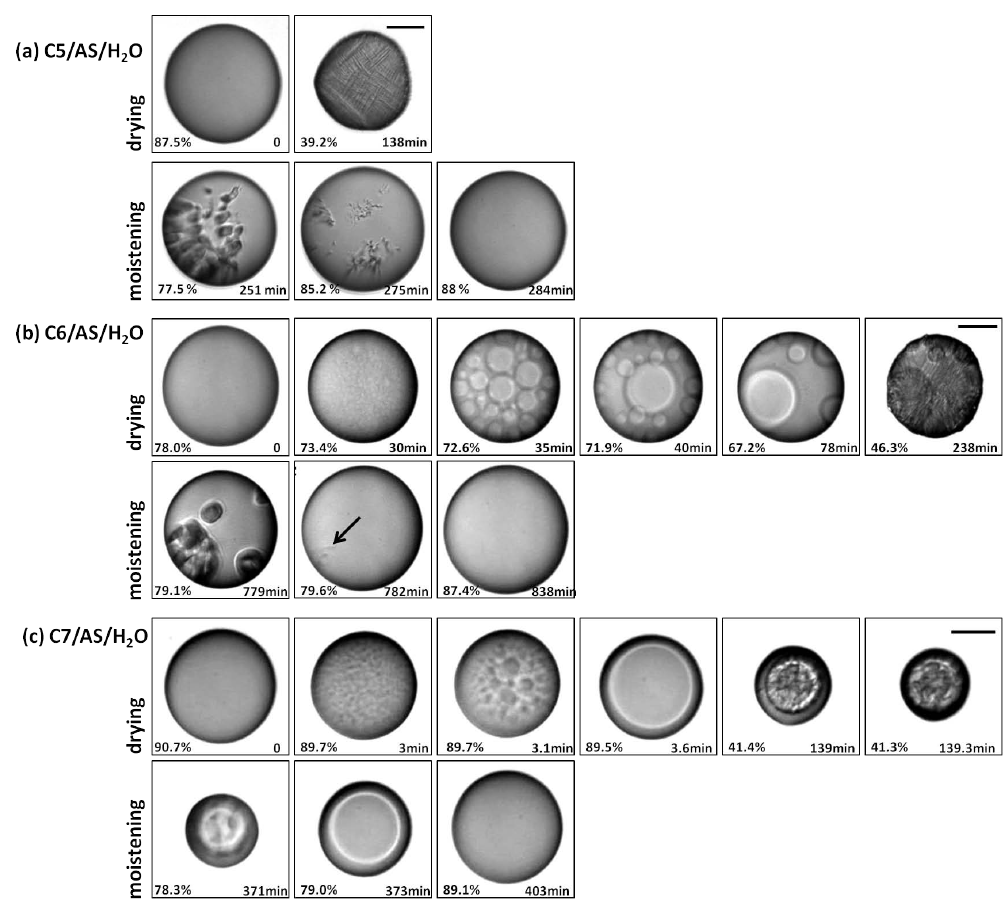
Fig. 2. Humidity cycles of (a) C5/AS/H 2 O particle (top rows, dRH/d t = ± 0.33%min − 1 ), (b) C6/AS/H 2 O particle (center rows, dRH/d t = ± 0.14%min − 1 ), and (c) C7/AS/H = ± 0.34%min − 1 ) all with OIR = 1:1. At time t = 0, all particles are 2 O particle (bottom rows, dRH/d t present as droplets with a single liquid phase. Size bar: